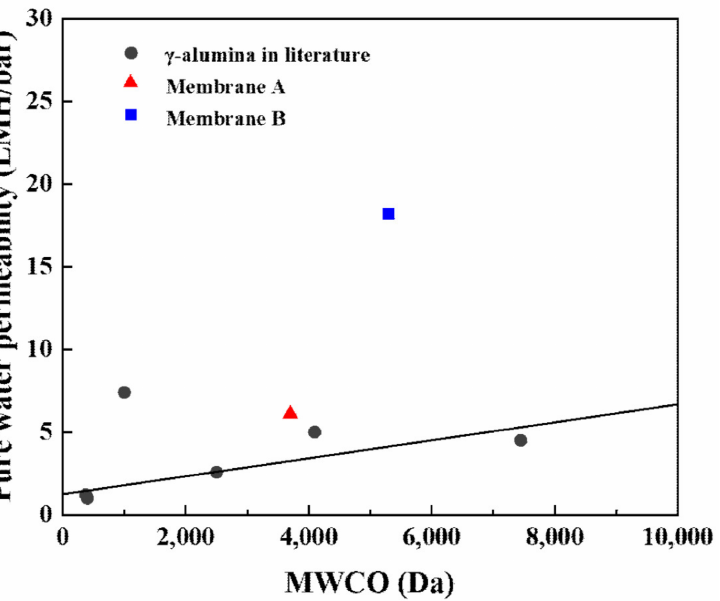
Figure 9. Correlation between MWCO values and pure water permeability of different γ -Al 2 O 3 tight ultrafiltration (UF) membranes reported in the